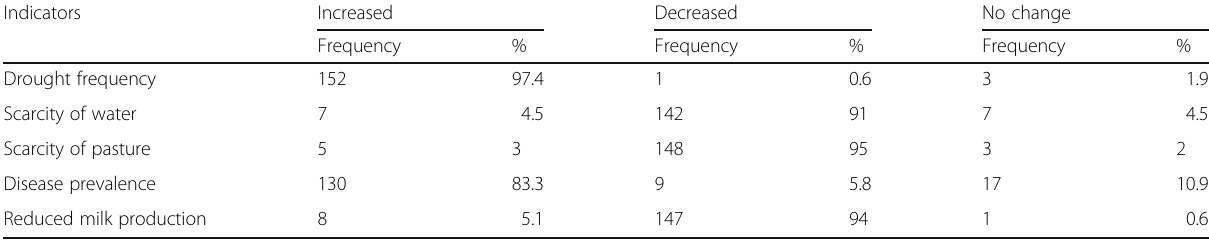
Table 2 Respondents ’ perceptions on trends of local indicators of climate change in terms of drought frequencies, scarcity of water and pasture, disease prevalence, and reduced milk production in Borana, southern Ethiopia Indicators Increased Decreased No change Frequency % Frequency % Frequency % Drought frequency 152 Scarcity of water Scarcity of pasture Disease prevalence Reduced milk